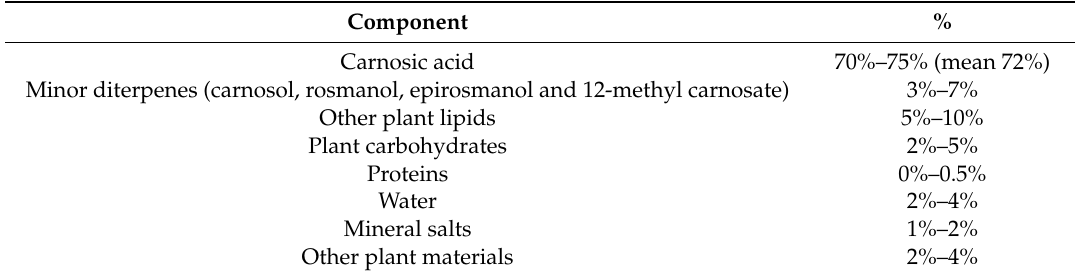
Table 1. Composition of the semipurified carnosic acid (CA) used in this